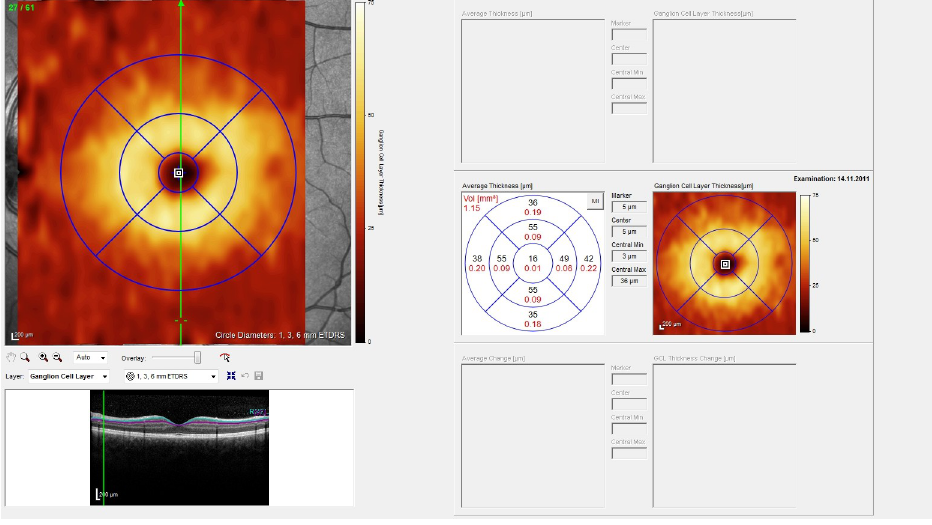
Fig 2. Macular scan, oculus sinister (OS). Upper left: fundus image with colours coding for GCL, lower left: OCT scan of retinal layers, right: GCL values per sector and coded by colours. Abbreviations: OCT–optical coherence tomography, GCL–ganglion cell